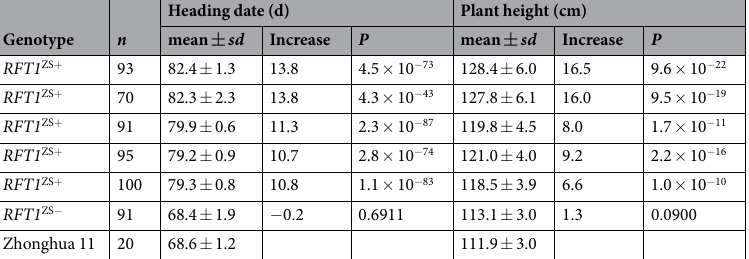
Table 4. Effect of the RFT1 ZS97 transgene on heading date and plant height. The five RFT1 ZS97 + T 2 families were derived from five independent T 1 plants carrying homozygous RFT1 ZS97 transgene. The RFT1 ZS97 − T 2 family was derived from a T 1 plant carrying no transgene. n , number of plants. The Student’s t -test was used to generate P values.